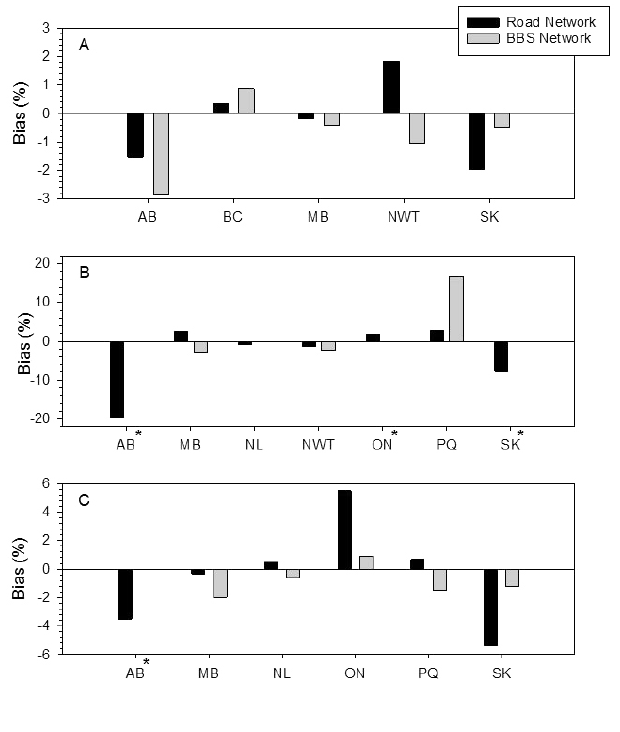
Fig. 4 . Overall bias in representation of forest fires along North American Breeding Bird Survey (BBS) routes compared against proportion of forest burned (2000-2012) in BBS strata within the full BBS network and the road network as a whole in (A) bird conservation area 6 (BCR 6; Boreal Plains), (B) BCR 7 (Taiga Shield and Hudson Plains), and C) BCR 8 (Boreal Softwood Shield). An asterisk (*) indicates that missing BBS network bars are because of no BBS coverage within the associated stratum and not zero